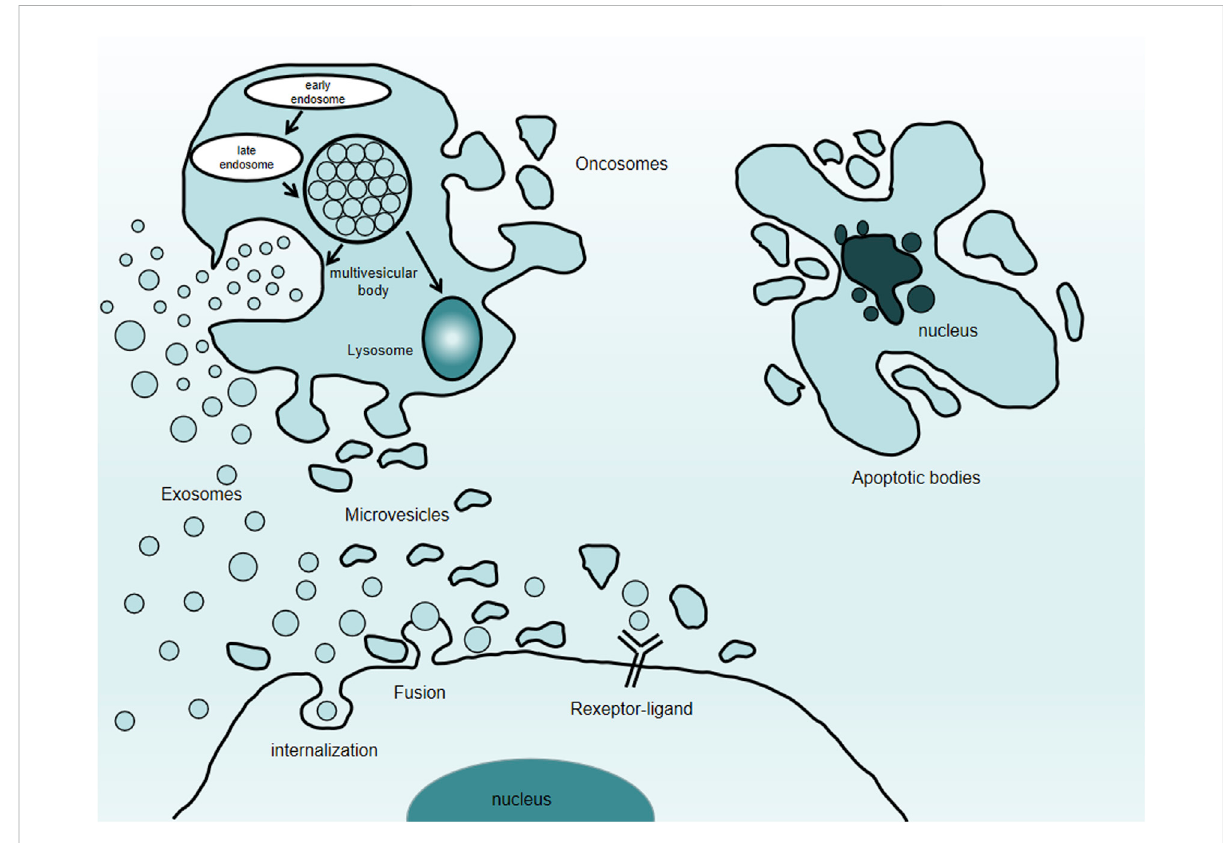
FIGURE 1 Types of extracellular vesicles. Extracellular vesicles comprise exosomes, microvesicles, oncosomes, and apoptotic bodies.